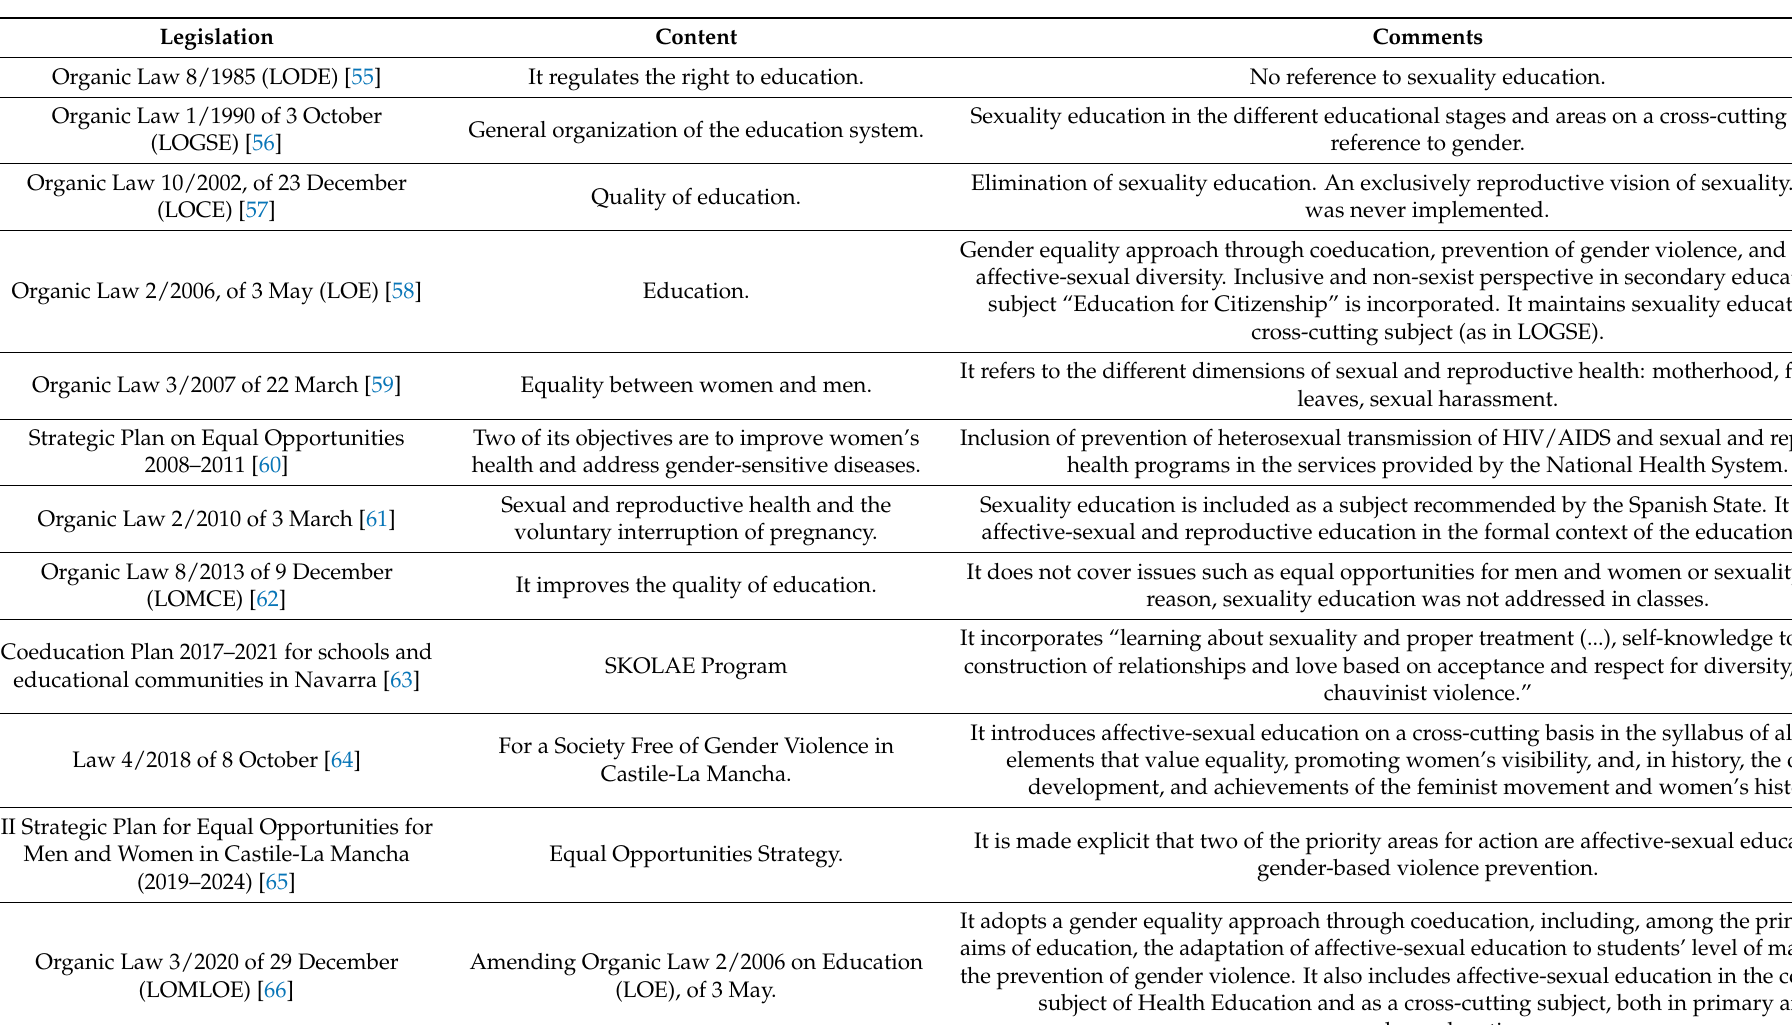
Table 3. Main legislation in